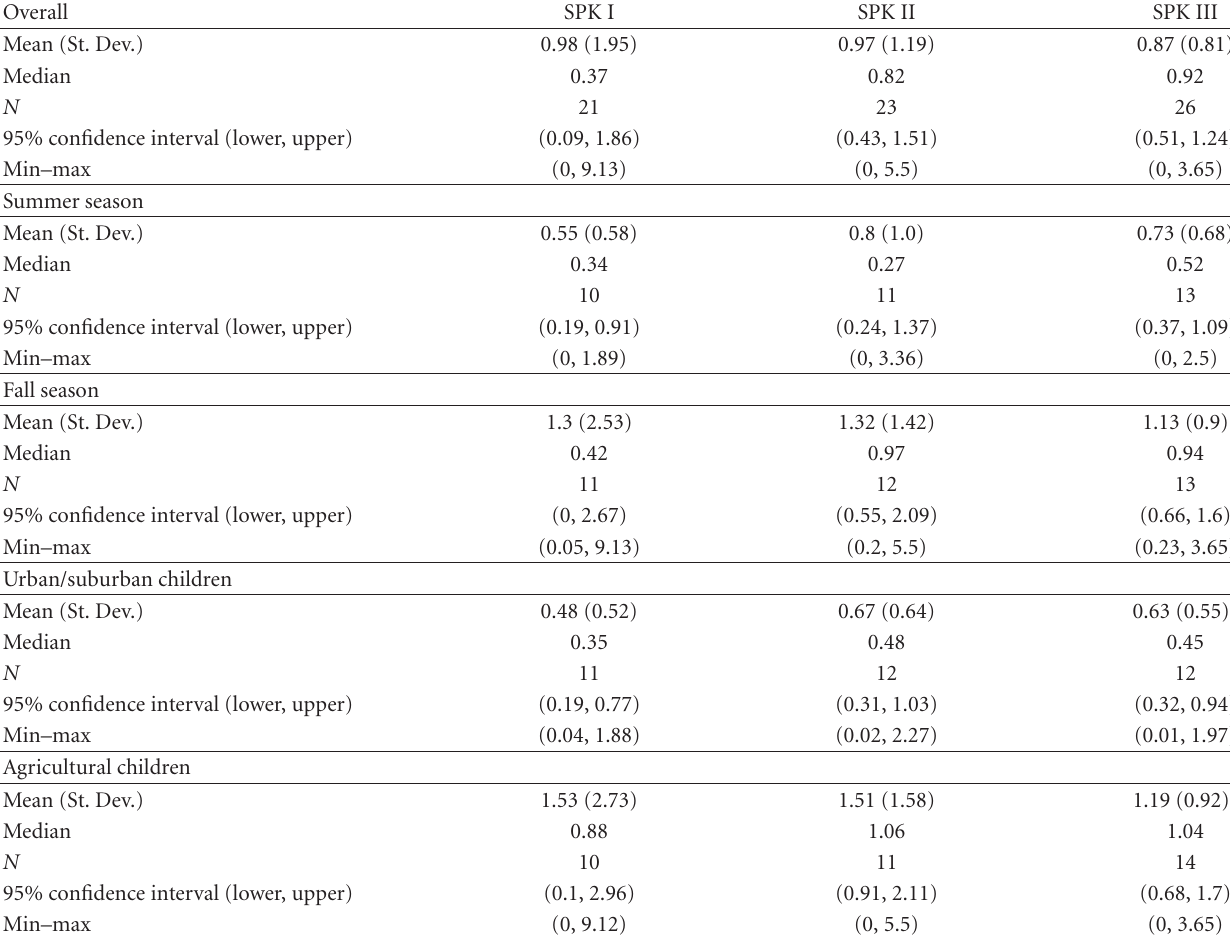
Table 1: Descriptive statistics for the estimated daily dose ( µ g/kg/day) of chlorpyrifos in thirteen children ages 2–5 using the simple pharmacokinetic model.